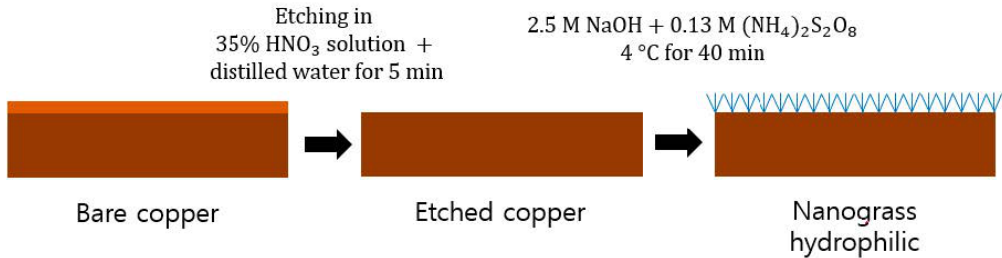
Figure 2. Fabrication process of the nanograss hydrophilic copper tube.